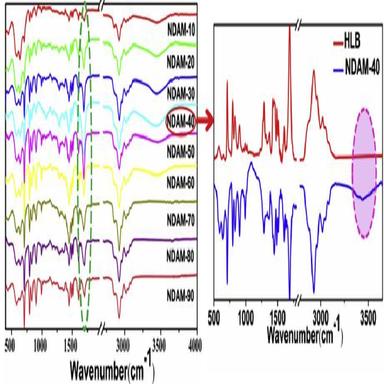
IR spectra of a series of NDAM and comparison between NDAM-40 and HLB.